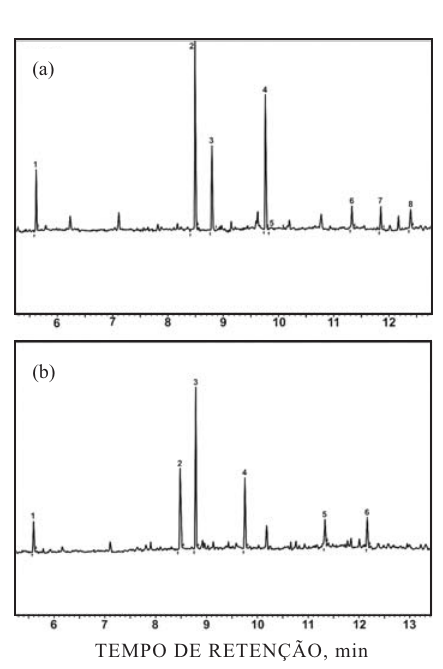
Figura 3. Cromatograma dos compostos orgânicos da subfração aromática presentes na humina extraída de amostras de solo degradado pela extração de argila, com vegetação espontânea [ Brachiaria mutica (Forsk.) Stapf] (A) e em área com Acacia mangium Willd